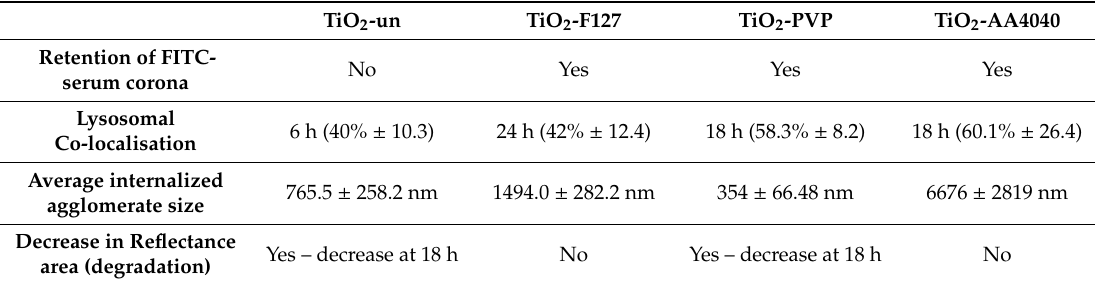
Table 1. Summary of the observed e ff ects of surface modification on the corona formation, uptake, and degradation of TiO 2 NMs. Surface modification results in the retention of a hard corona, which a ff ects the nature of particle uptake and distribution over time. Most notably, these are observed as changes in the size of internalized agglomeration and the rate at which particles are degraded (observed as a reduction in the reflectance signal after 18 h in uncoated and PVP-modified